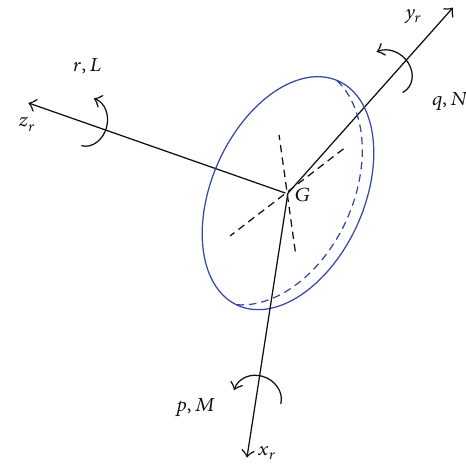
Figure 6: Rotor in moving frame of